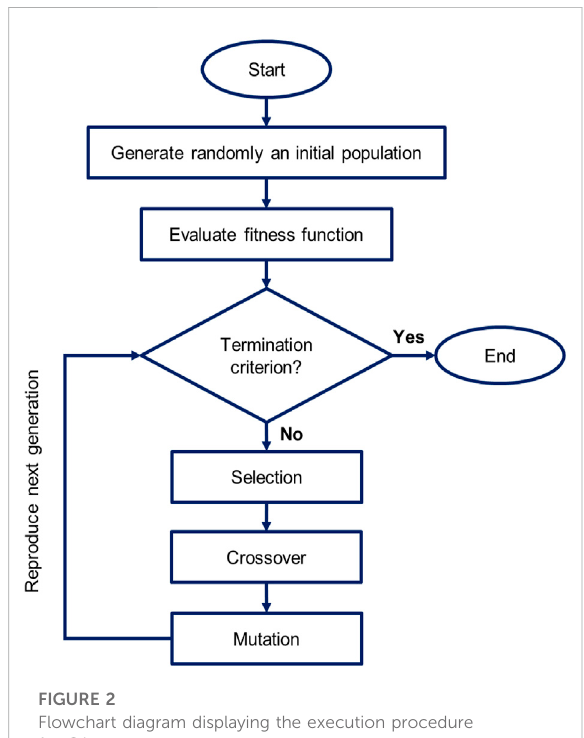
FIGURE 2 Flowchart diagram displaying the execution procedure for